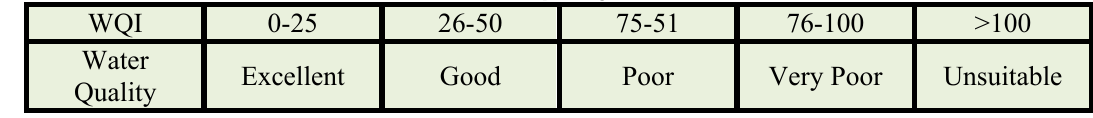
Table1: Water quality index